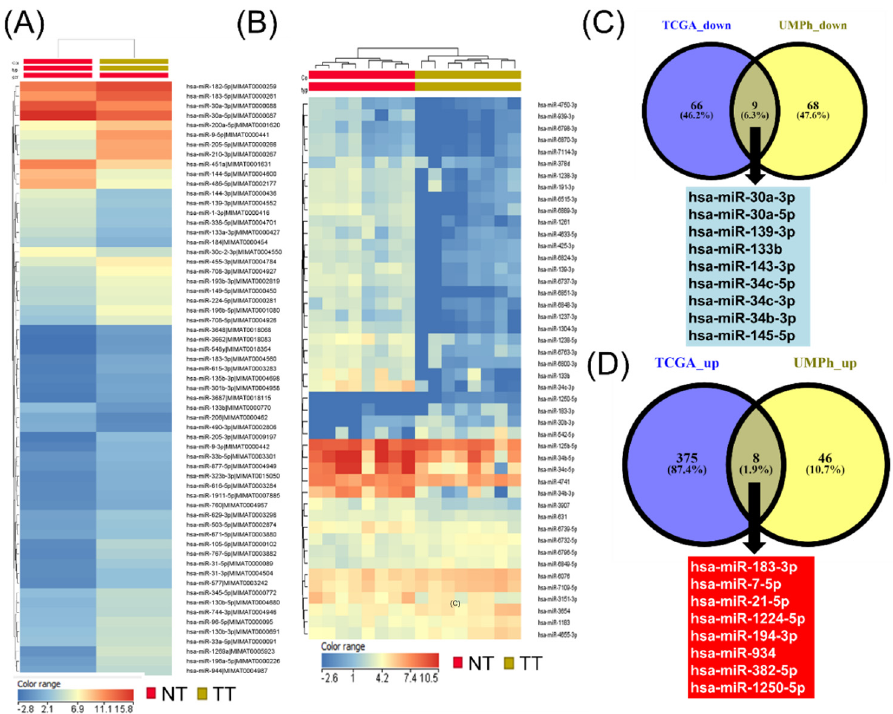
Figure 1. miRNA profiling in NSCLC male patients. ( A ) Heatmap for the TGCA dataset. ( B ) Heatmap for UMPh patient cohort (the blue color denotes underexpression, whereas the red color suggests overexpression). ( C ) Venn diagram for underexpressed miRNAs between TCGA (blue) and UMPh (yellow) cohorts. ( D ) Venn diagram for overexpressed miRNAs between TCGA (blue) and UMPh (yellow) cohorts.